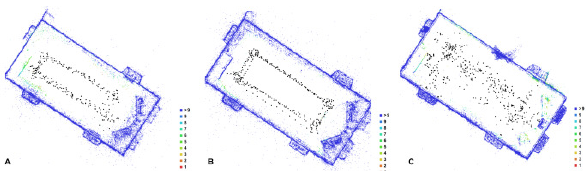
Figure 4. Image distribution: a) Xiaomi Yi 2k, b) Xiaomi Yi 4k, c) Canon 5D Mark II